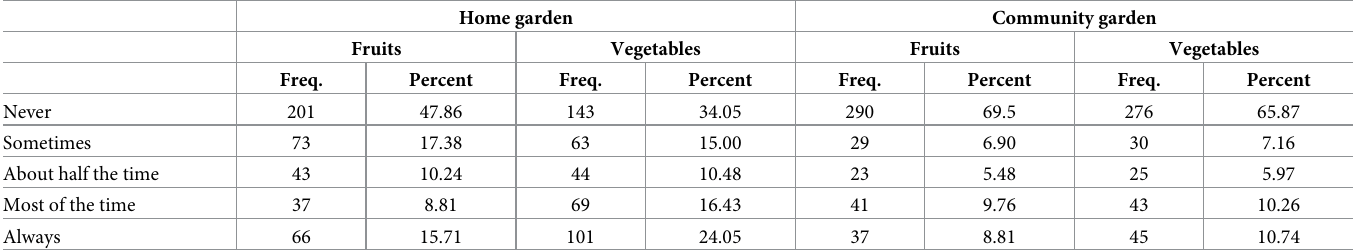
Table 1. Growing fruits and vegetables.